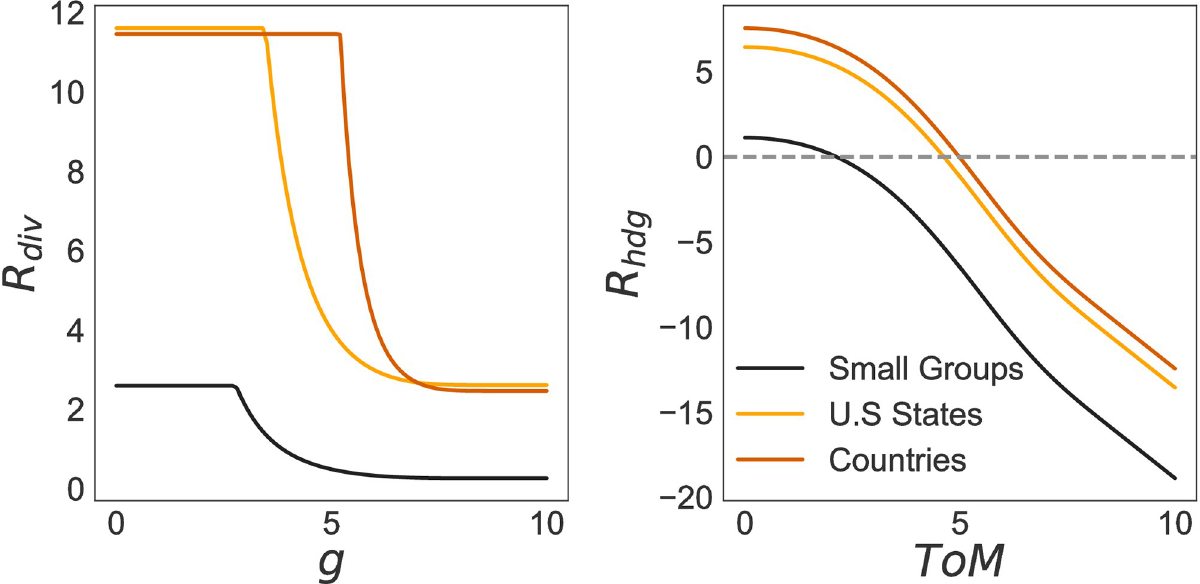
Fig 6. Effect of g on the need for R , and ToM on the ability to close representational gaps R in solving complex problems for the best-fit div hdg parameter values reported in Table 1. The dotted line indicates where R is not detrimental to the ability of finding solutions anymore (i.e. = 0). hdg Additional ToM is then spent to better achieve solutions rather than closing representational